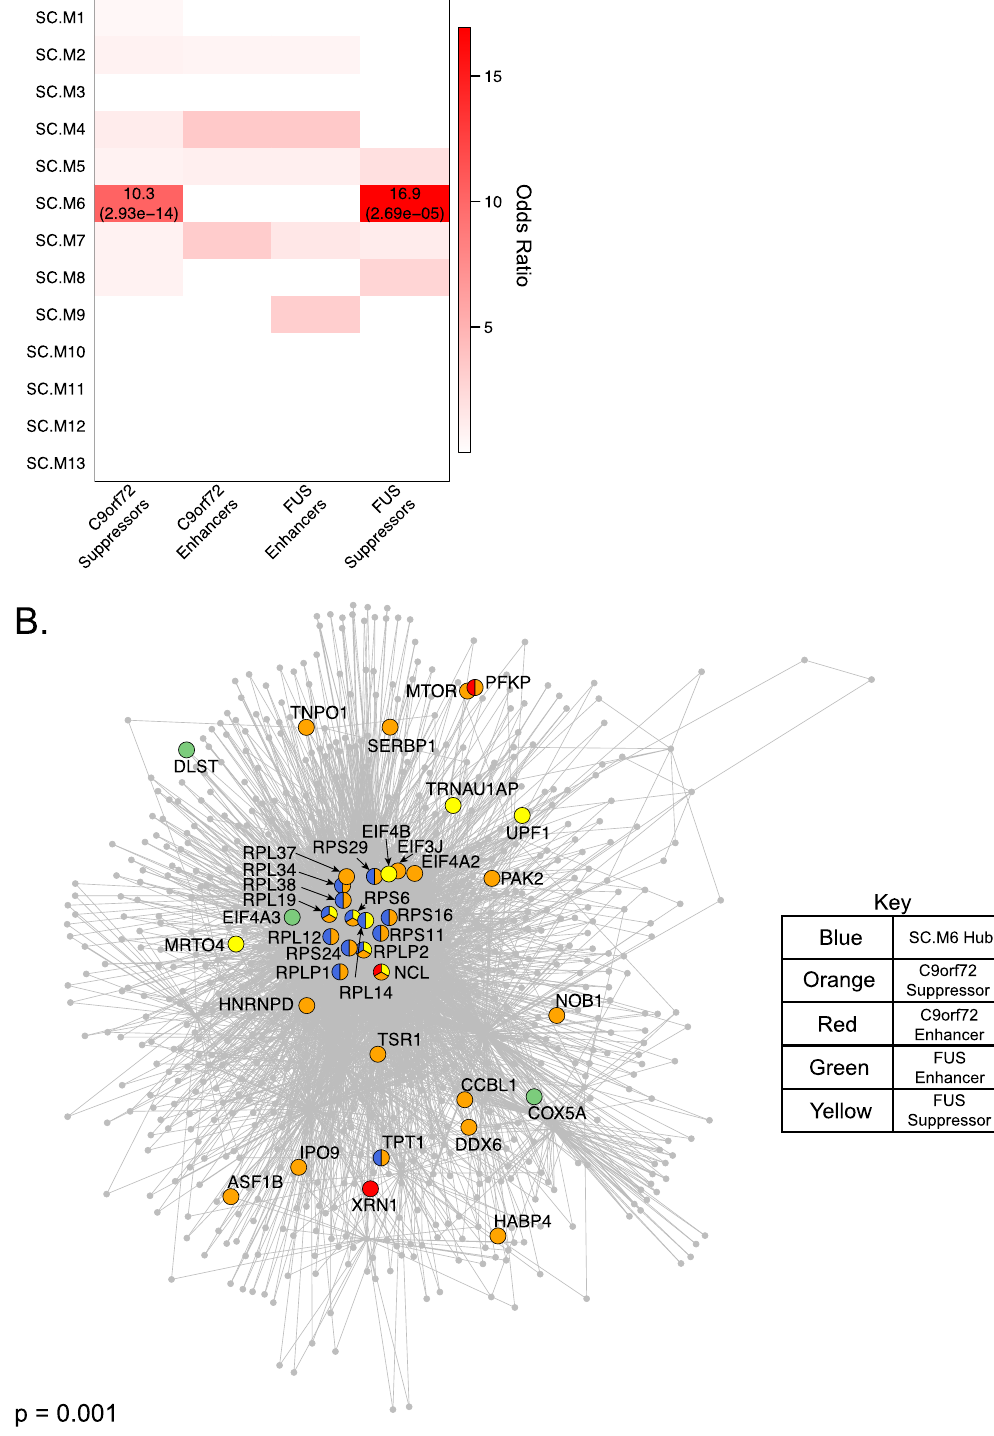
Figure 4. Modifiers of C9orf72 and FUS toxicity converge on top hubs of ribosomal-associated module SC.M6. ( A ) Enrichment of genetic modifiers of C9orf72 and FUS toxicity 26–28 within co-expression modules. Odds ratios of enrichments with FDR corrected p-value < 0.05 are shown. FDR corrected p-values themselves are shown within parentheses. ( B ) Indirect protein–protein interaction (PPI) network of the top 100 hub genes from module SC.M6. Gene vertices are color coded as shown. P-value of the PPI network is derived from 1000